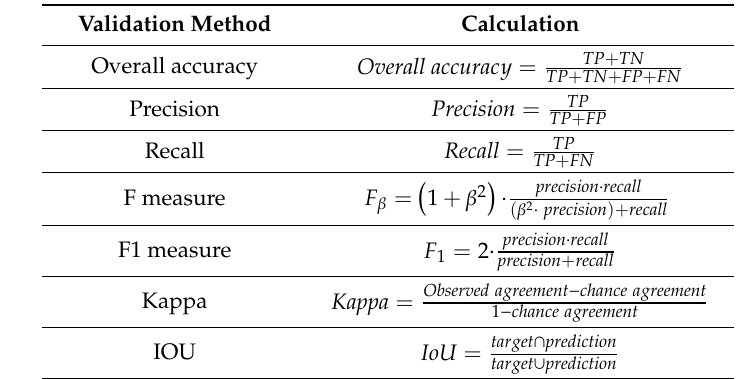
Table 3. The calculation of each validation method. IOU—intersect over union; TP–true positive; TN–true negative.